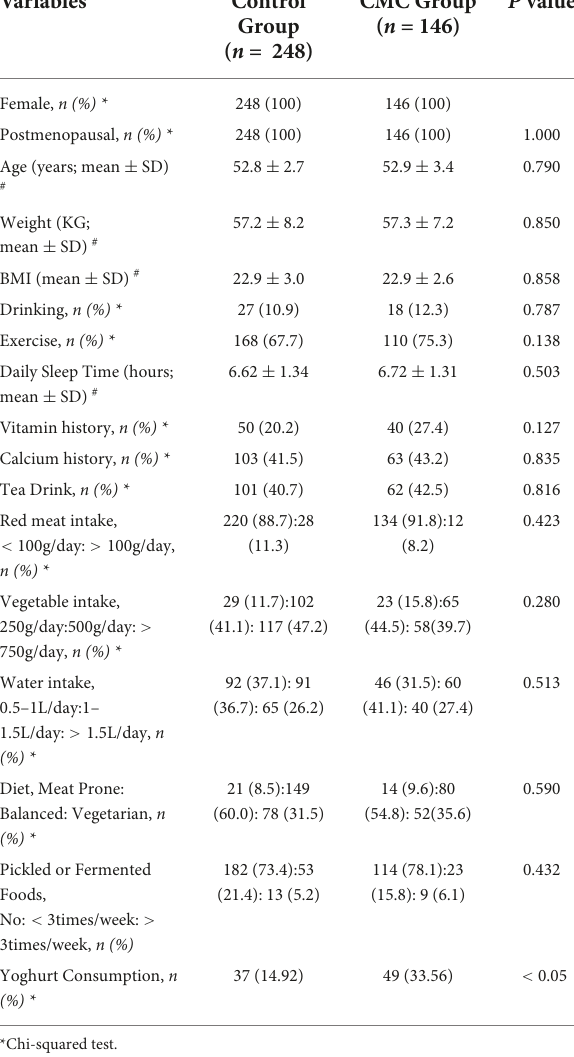
TABLE 1 Characteristics of Chinese subjects included in the study.